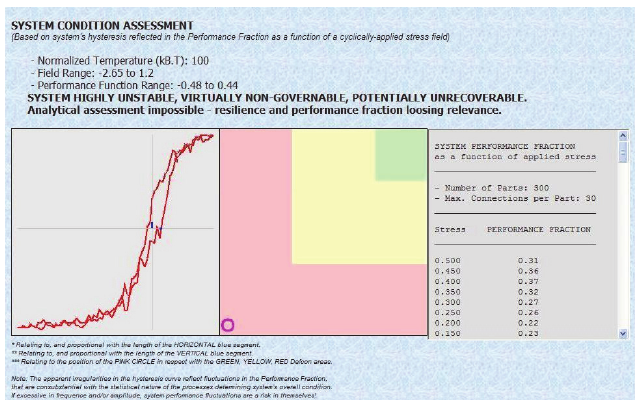
Figure 5. Hysteresis in a 300-part, 30-part links/part system, at a normalized temperature 100 units. System unstable, virtually non-governable and potentially